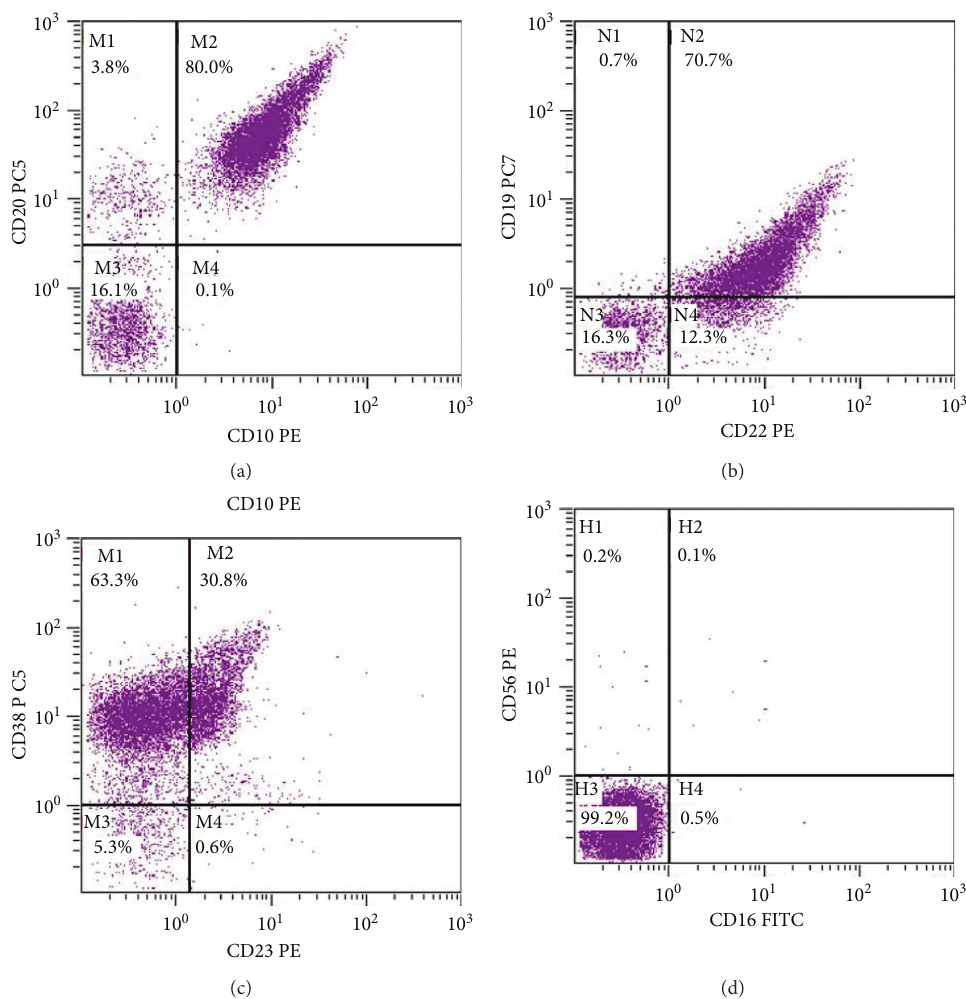
Figure 2: Flow cytometry from a neck mass in a 17-year-old female demonstrating neoplastic (a) CD20-positive B-cells with CD10 co- expression. The neoplastic cells demonstrate positive expression for (b) CD19, CD22, and (c) CD38 with (d) no CD16 or CD56